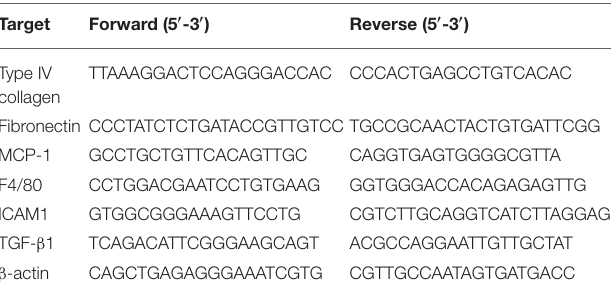
TABLE 1 | Nucleotide sequences of the primers used for quantitative real time PCR.